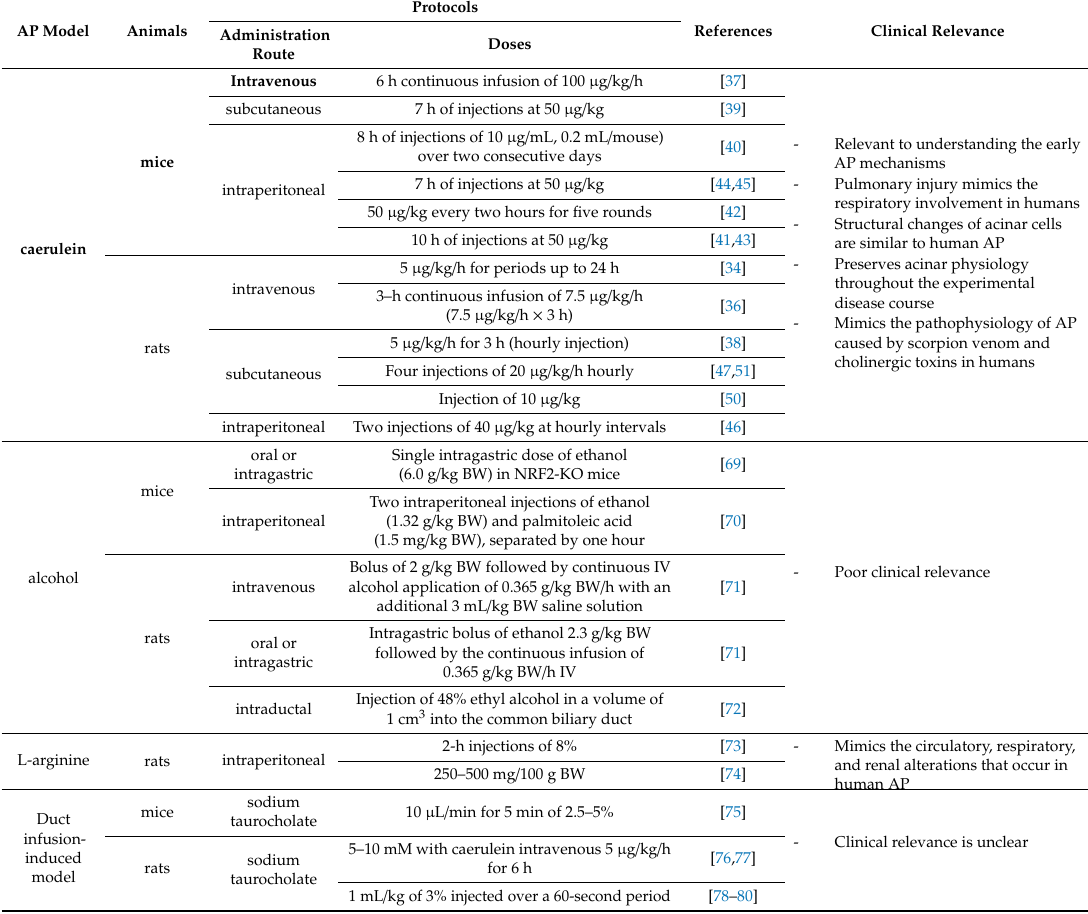
Table 3. Protocols of the most used acute pancreatitis (AP) models in mice and rats. BW: body